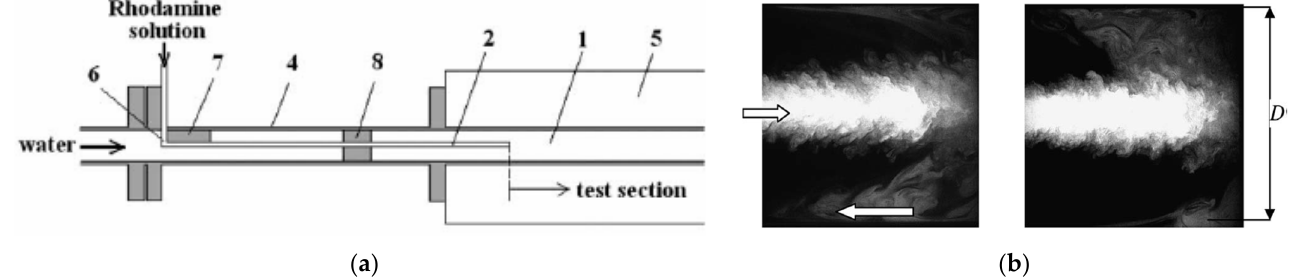
Figure 32. ( a ) Schematic diagram of the experimental setup. ( b ) Instantaneous flow patterns of the scalar field in the mixing regime at a time interval of 1 s [95].